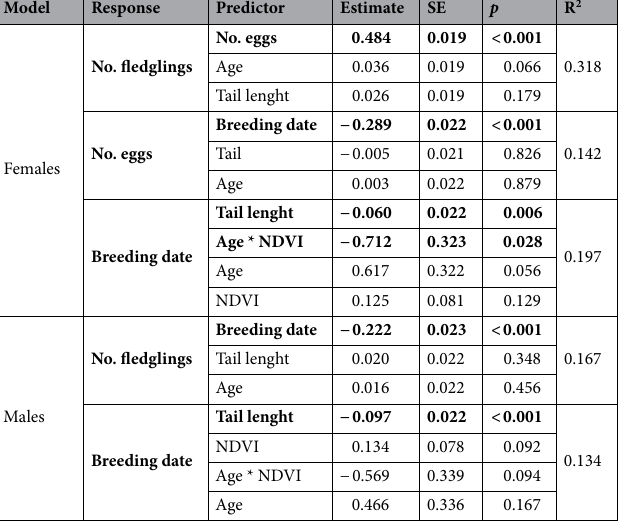
Table 2. Summary results from confirmatory path analyses built for each sex class. Estimates shown here are standardized path coefficients (i.e. slopes of effects). R 2 shown here is the conditional R 2 , based on fixed and random effects. Significant effects are highlighted in